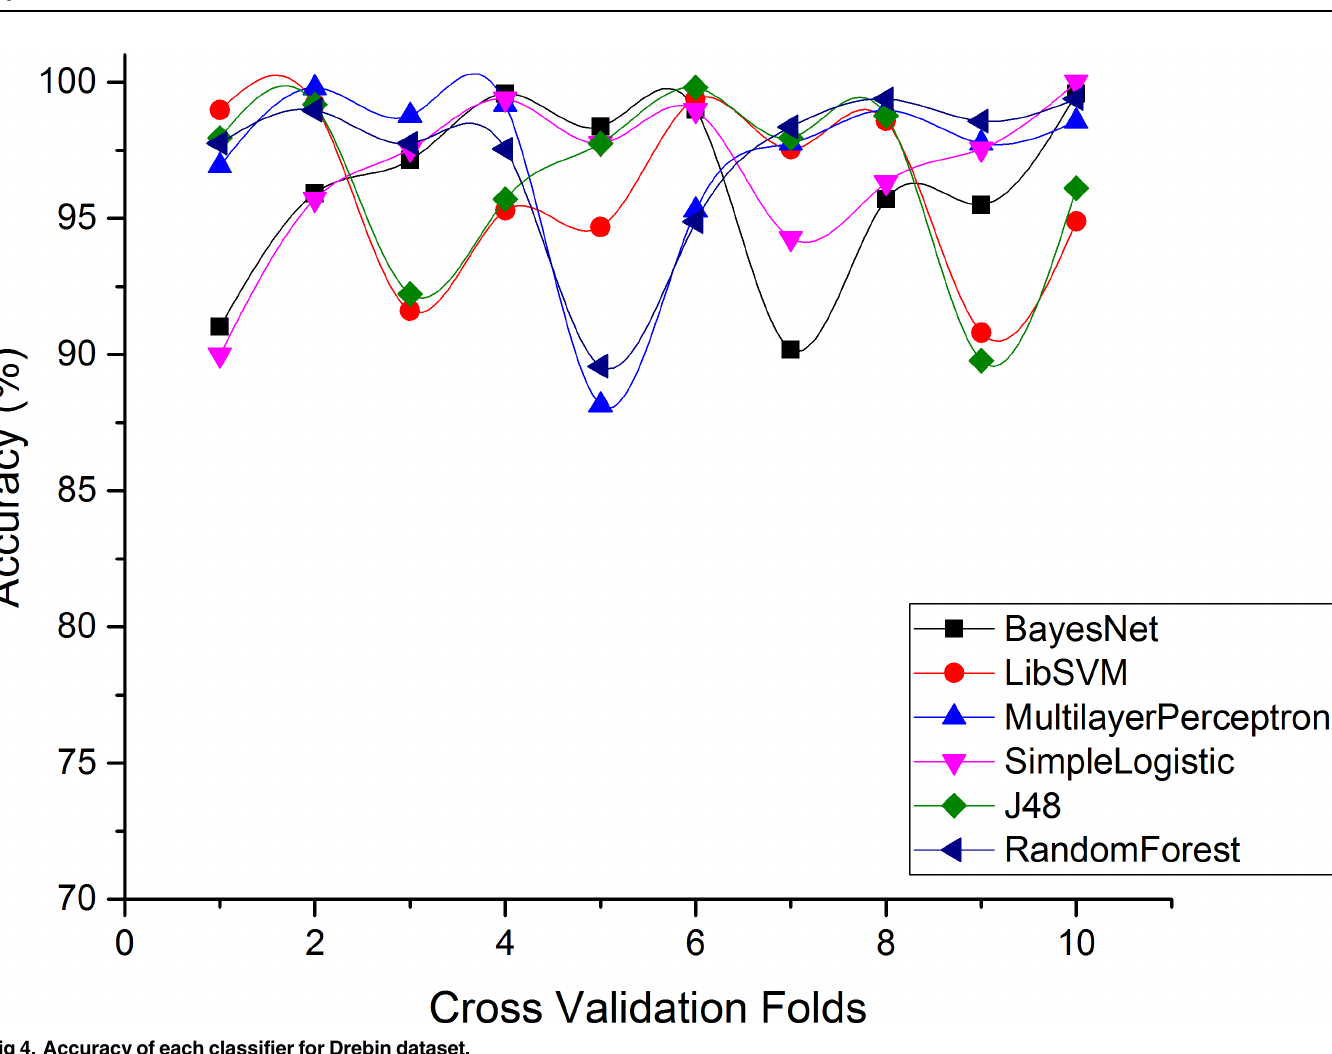
Fig 4. Accuracy of each classifier for Drebin